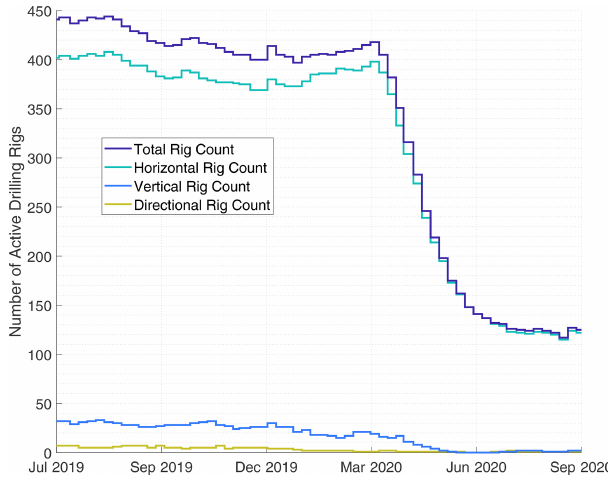
Figure 2. Weekly count of active drilling rigs by type in the Permian Basin between July 2019 and August 2020 (Baker Hughes,